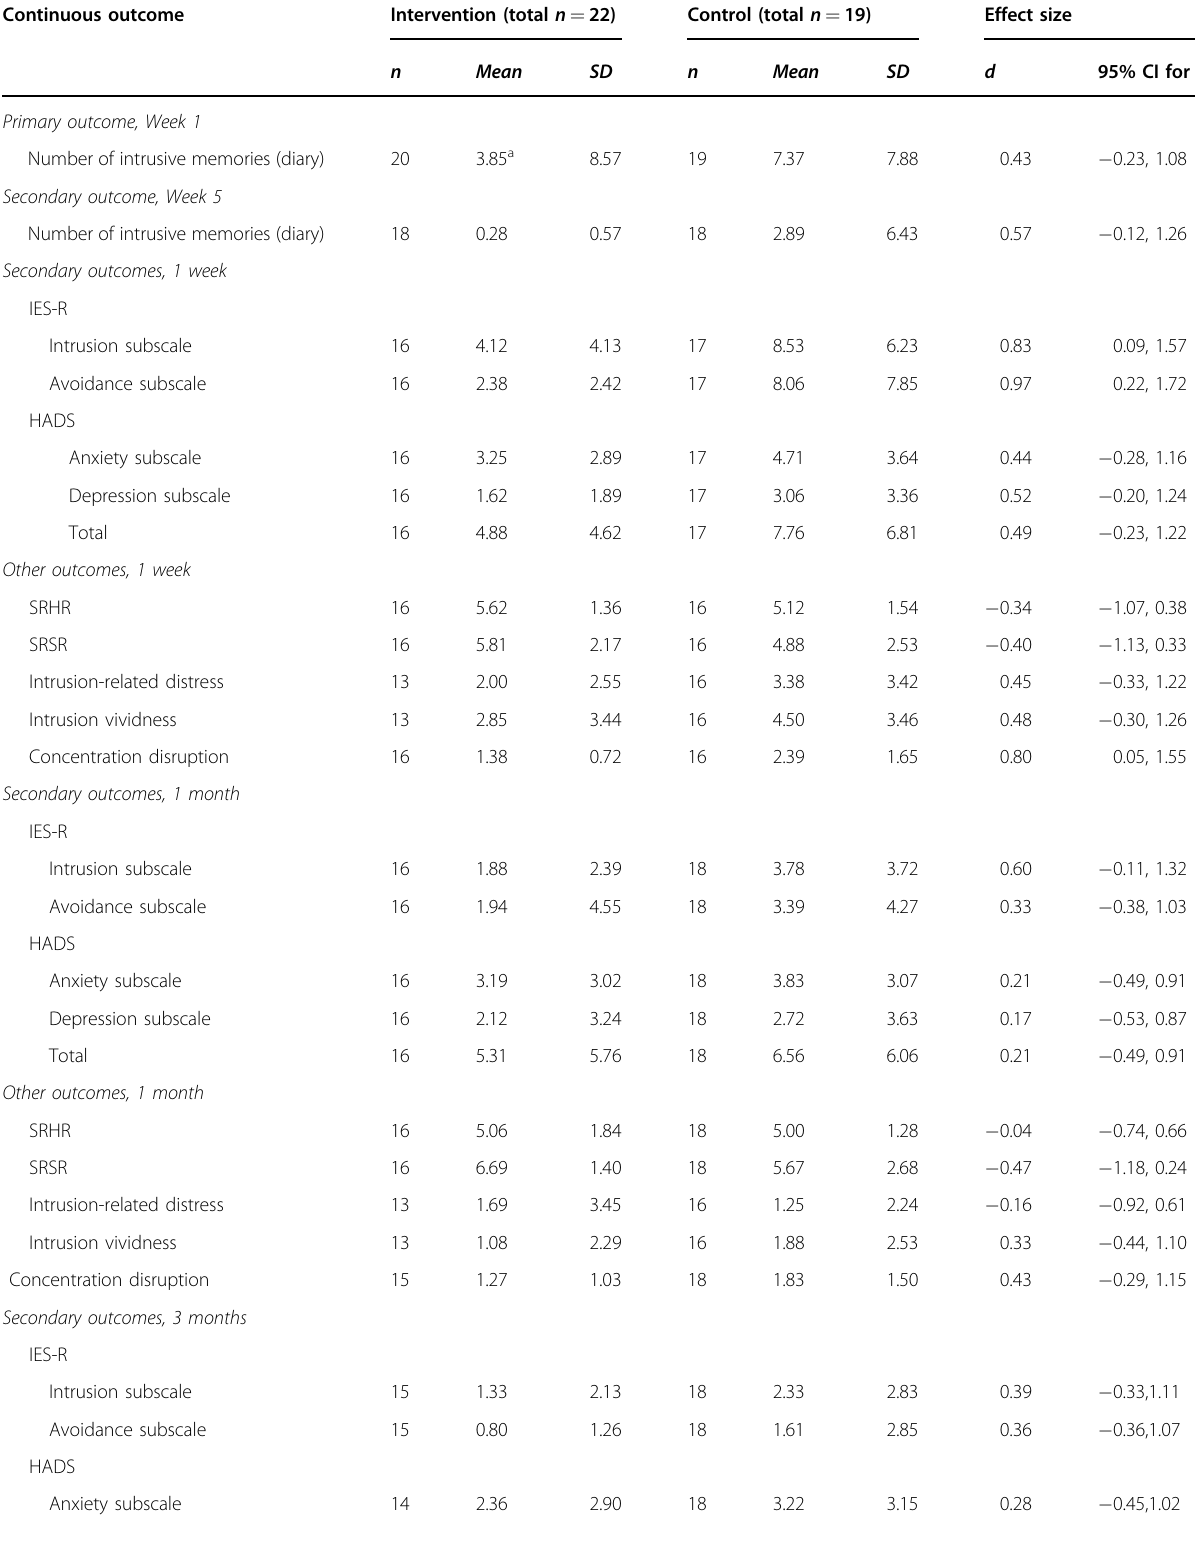
Table 3 Primary, secondary and other pre-speci fi ed outcome measures by condition. Continuous